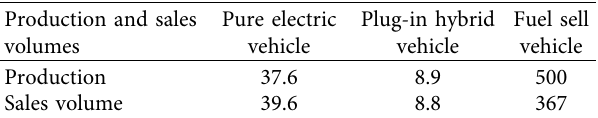
Table 2: Production and sales of new energy